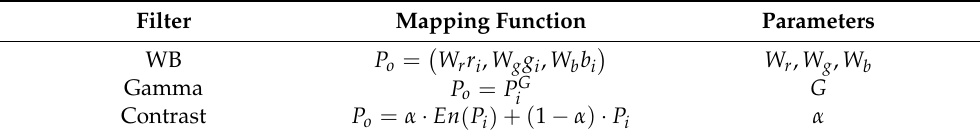
Table 1. The mapping functions of the three filters and the parameters to be optimized. Filter Mapping Function